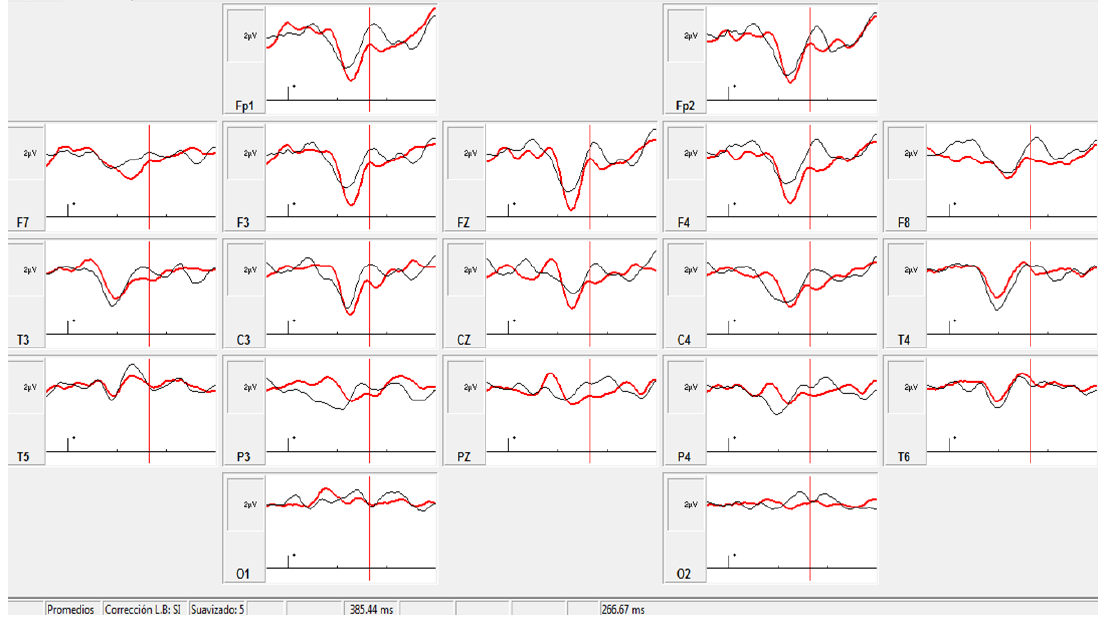
Figure 4. Grand averaged infrequent target. Black trace: pre-intervention (Amplitude and latency at Fz: 3.09 μV, 410 ms); red trace: post-intervention (Amplitude and latency at Fz: 3.28 μV, 371 ms).